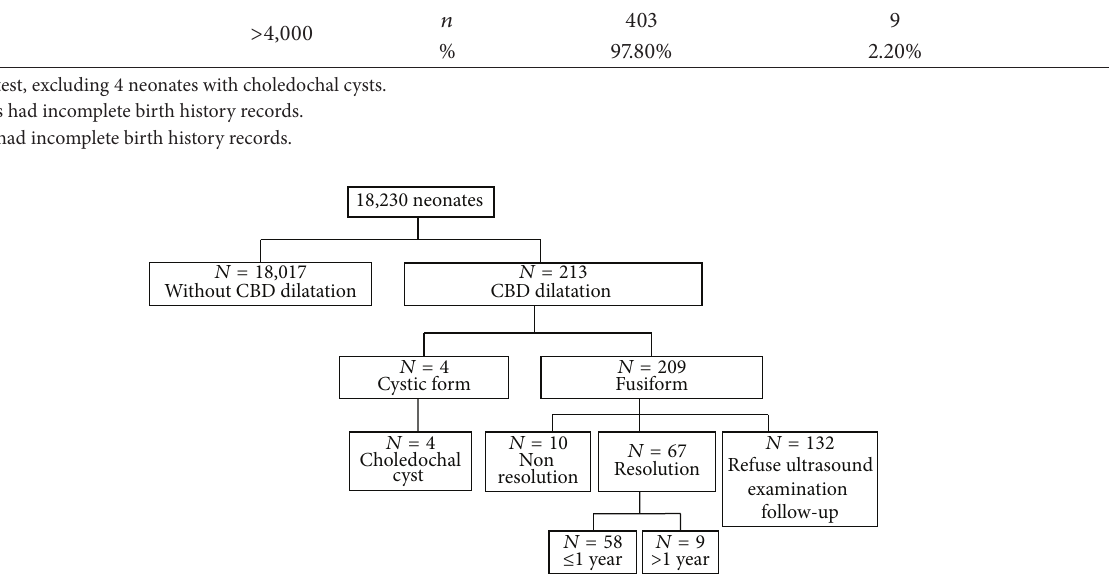
Figure 2: Overall initial and follow-up results of neonates who received abdominal ultrasound as newborn screening. CBD: common bile duct. 𝑁 : number of